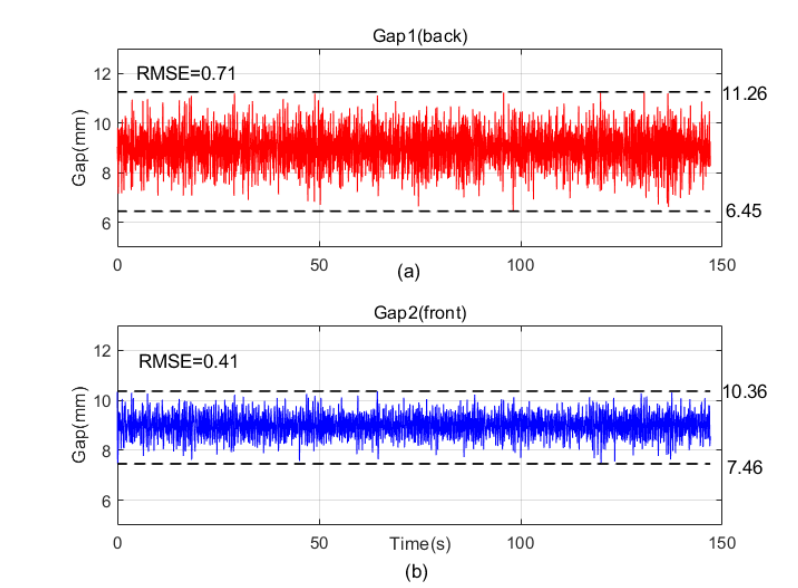
Figure 8. Levitation gap signals in numerical simulation at 80 km/h. ( a ) Gap1 (back), ( b ) Gap2 (front).